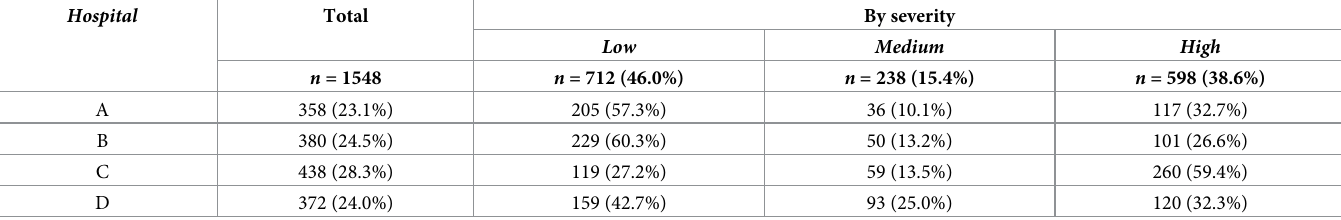
Table 1. Distribution of patients in our cohort. Total number and percentage of cases: by SARS-CoV-2 pneumonia severity group, and by hospital (anonymized).